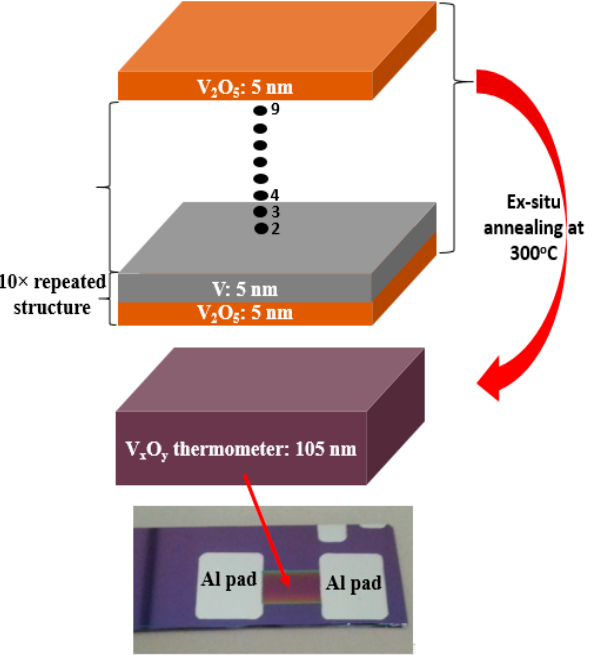
Figure 1. A schematic diagram of the synthesis process of the V x O y thin films. A photograph of the fabricated resistive thermometer (bottom).